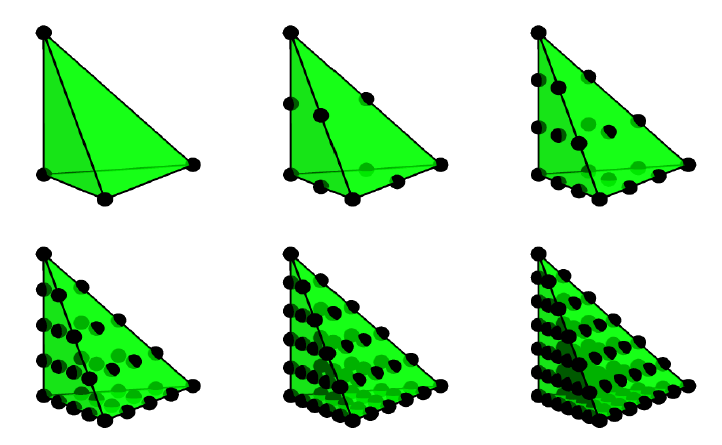
Figure 3. Continuous Lagrange tetrahedron for order = 1, 2, 3, 4, 5,